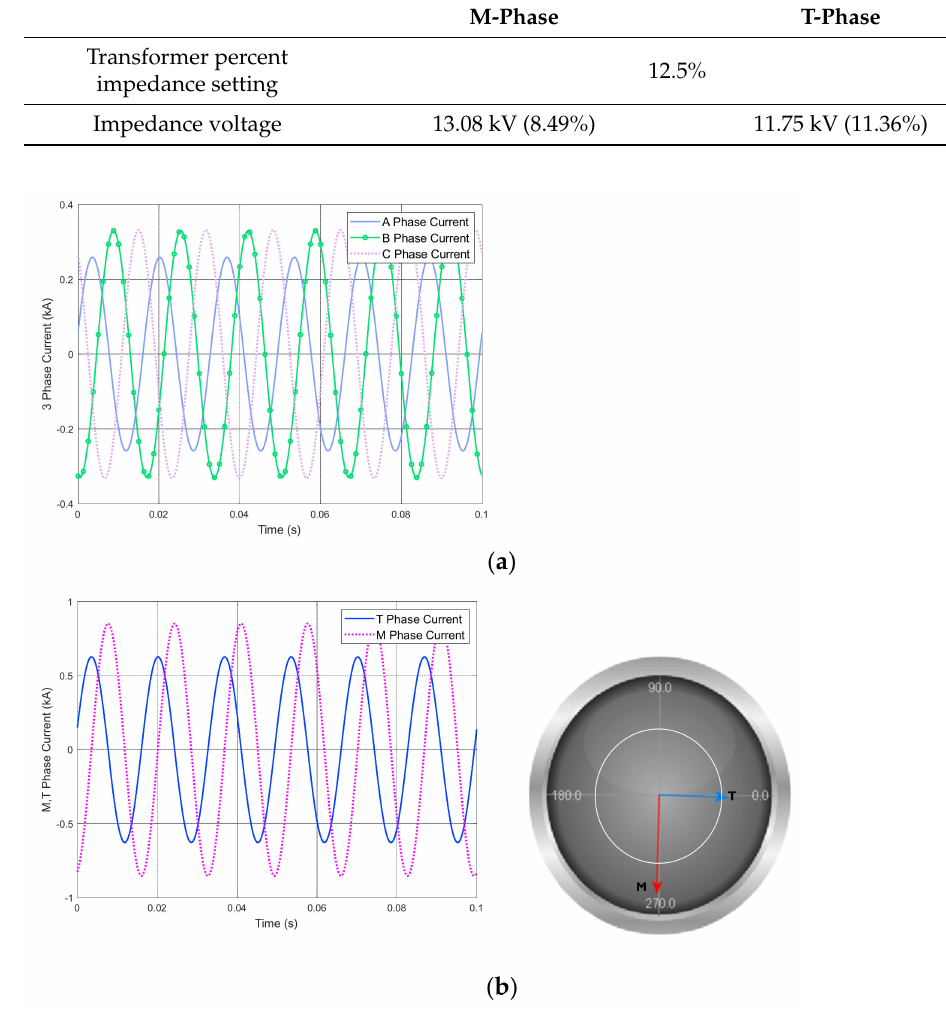
Figure 5. Impedance voltage test result for the Library Scott transformer model: ( a ) unbalanced three- phase current waveform; ( b ) unbalanced M- and T-phase current waveforms and vector